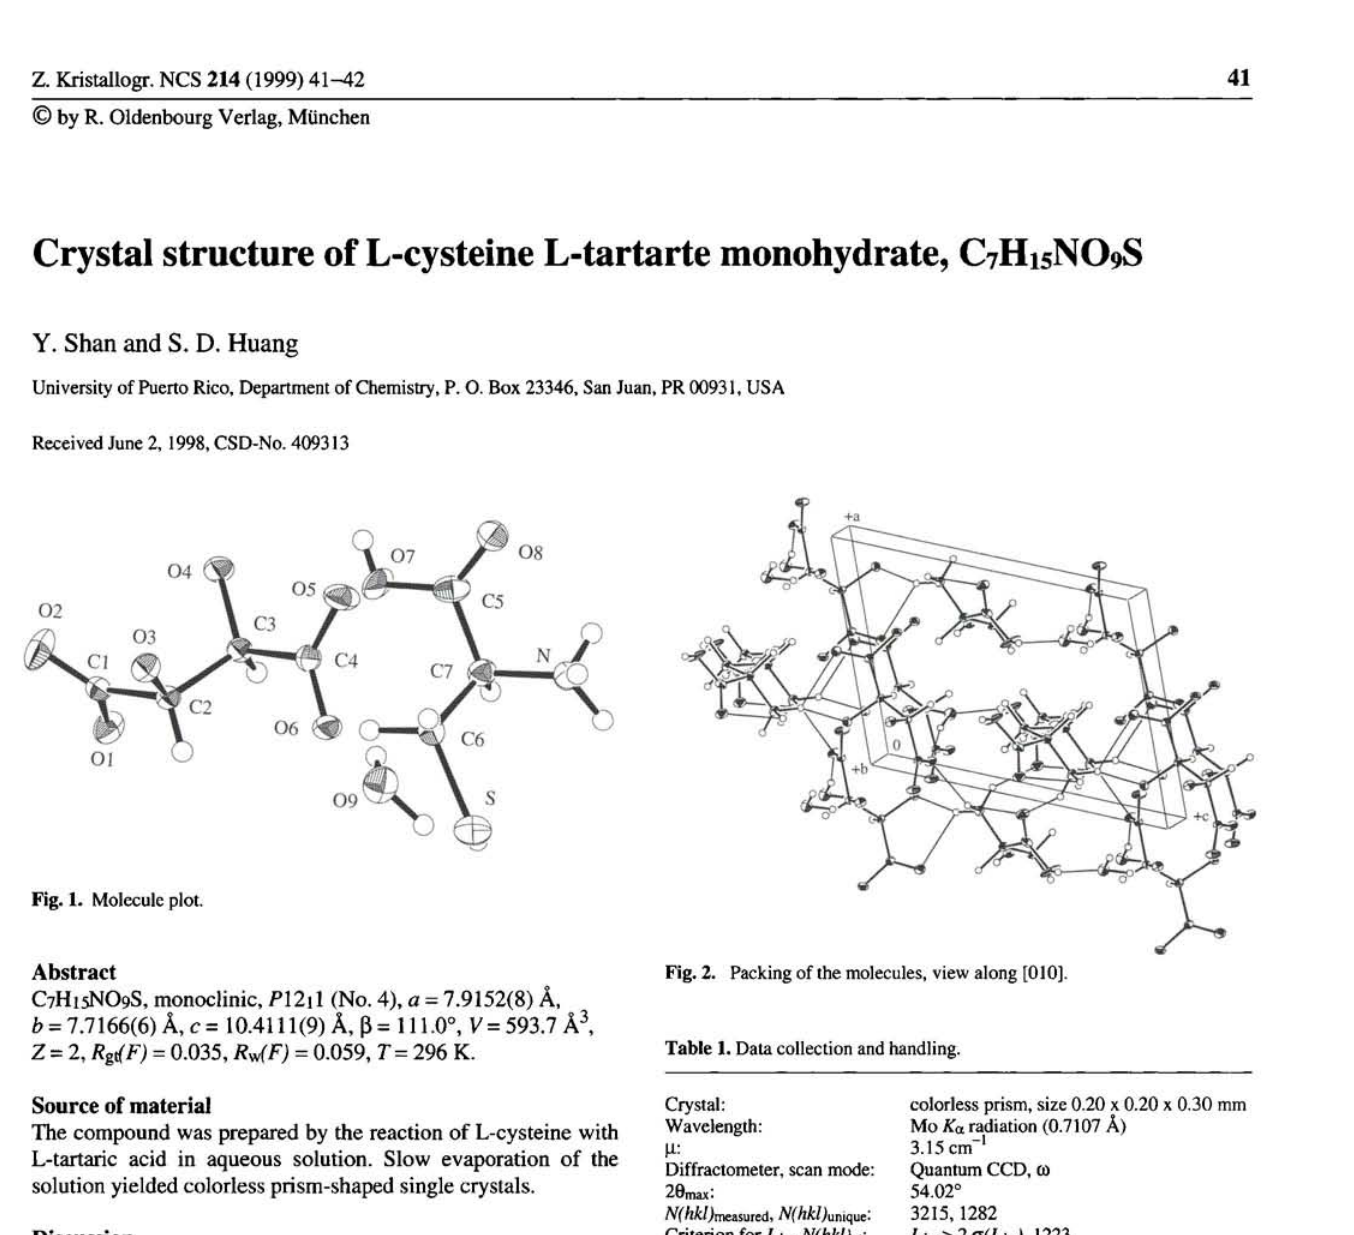
Table 1. Data collection and handling.